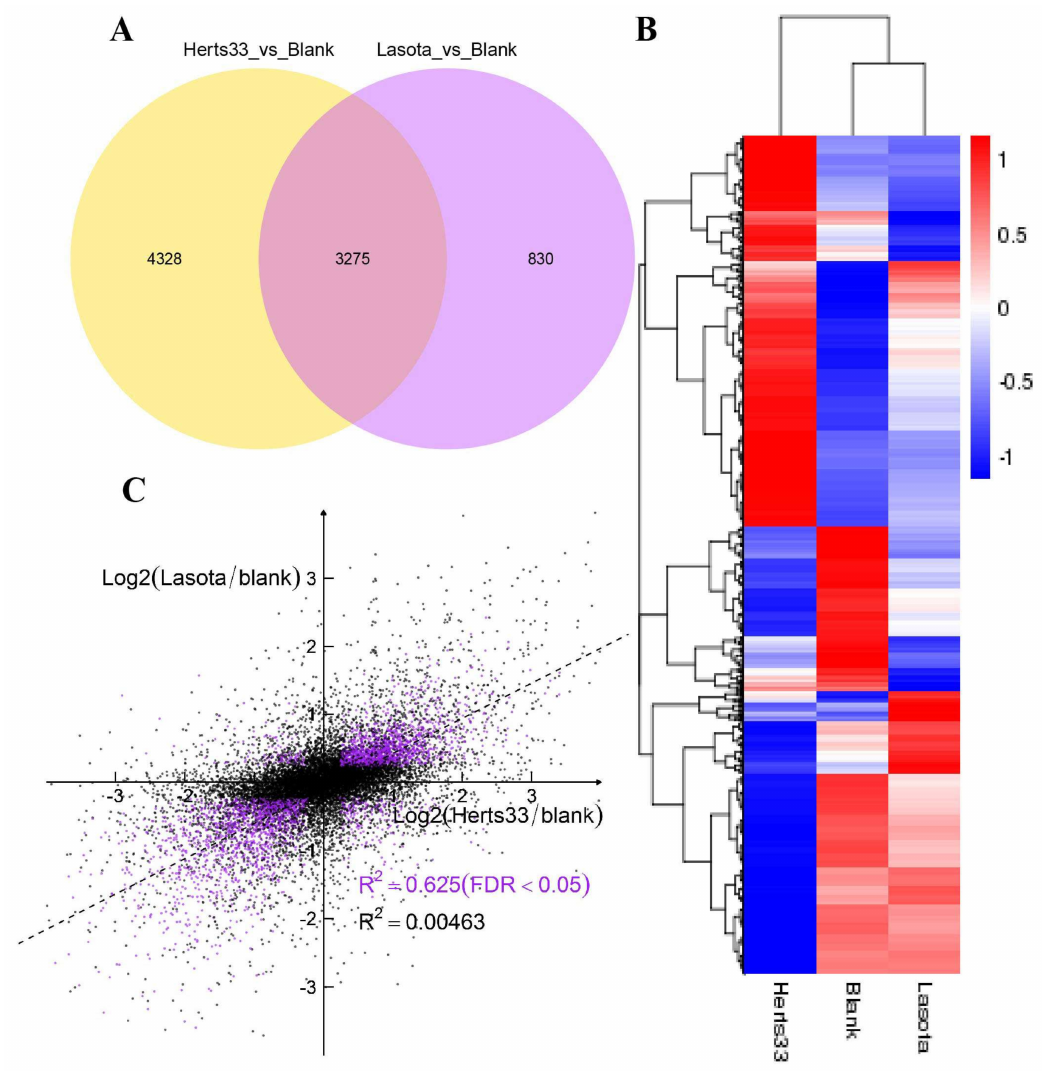
Figure 1. Summary of differentially expressed genes among the blank, Herts/33 and LaSota samples. ( A ) A Venn diagram of common differentially expressed genes when comparing two groups (blank vs. Herts/33 and blank vs. LaSota). ( B ) A hierarchical heat map showing transformed expressional values for the transcripts. Red indicates up-regulation and blue down-regulation. ( C ) Herts/33 and LaSota showed weakly correlated responses at the transcriptional level. Scatter plots reflect log2-transformed values for differential Herts/33 (x-axis) and LaSota (y-axis) expression relative to the blank control. All of the differentially expressed genes are indicated by black dots. Purple dots indicate differentially expressed genes with a cut-off threshold of false discovery rate (FDR) adjusted p -value < 0.05. The Spearman correlation coefficient (R) is also shown in